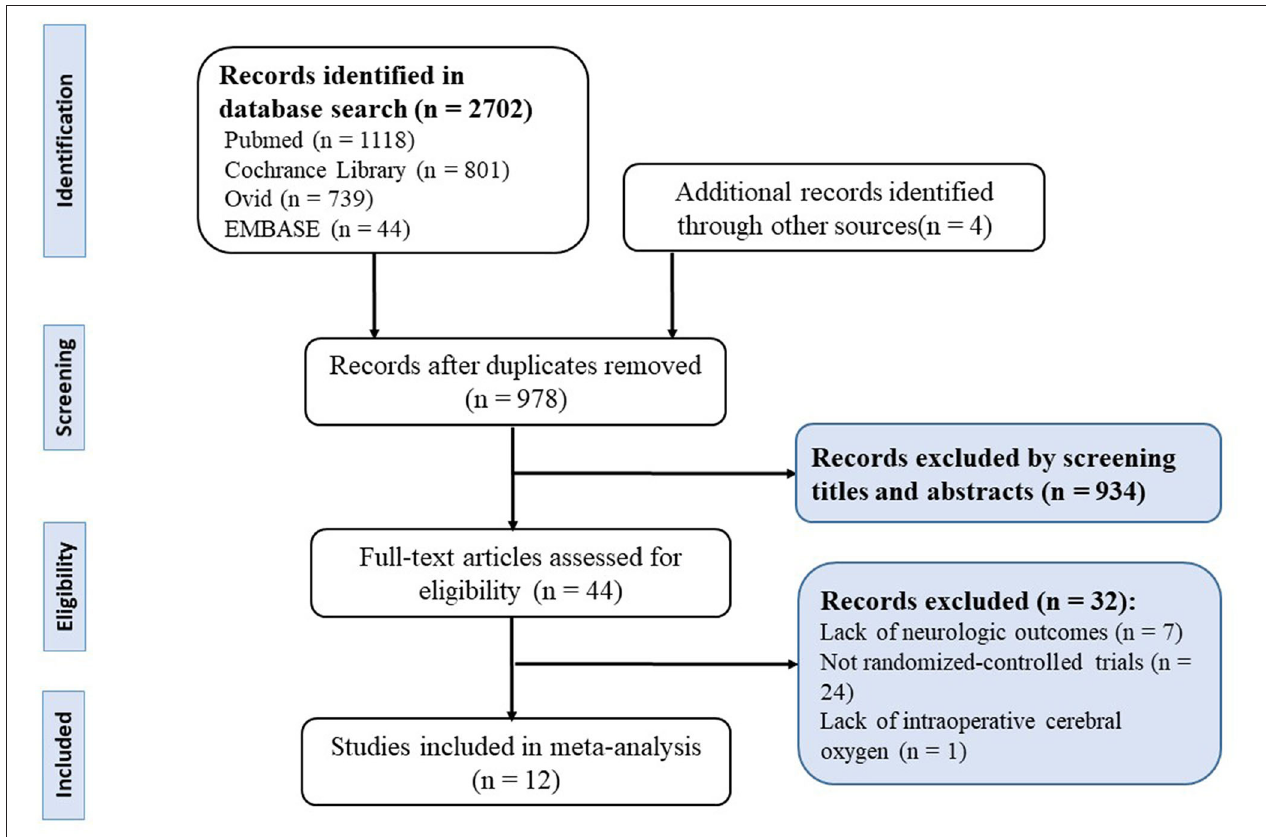
FIGURE 1 | Preferred reporting items for systematic reviews and meta-analyses (PRISMA) flowchart of selection.